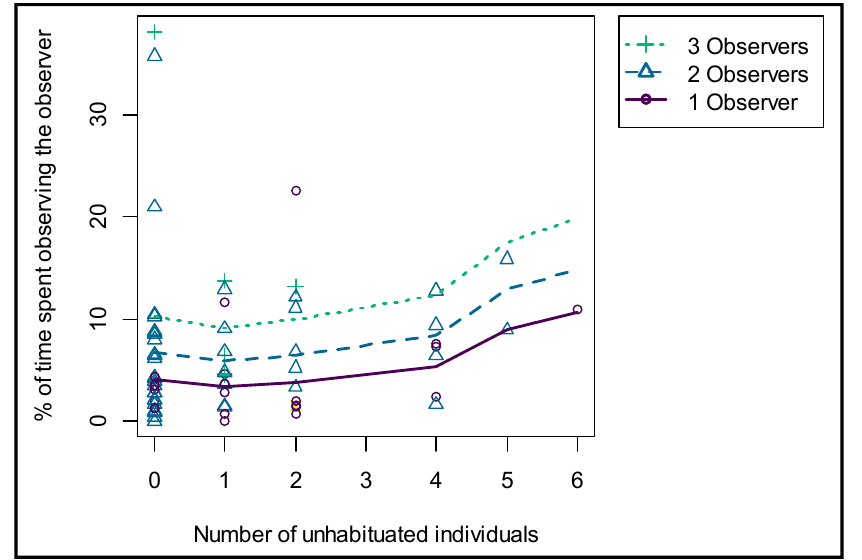
Figure 6. Effect of the number of observers and the number of unhabituated giraffes present on the time spent OO by the focal individuals.